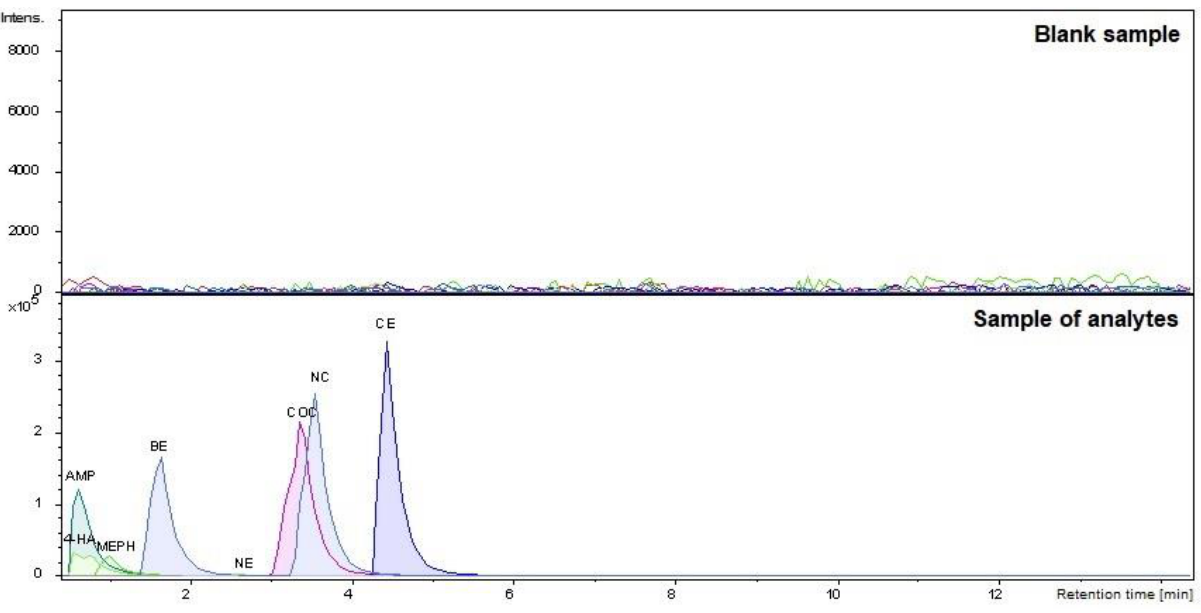
Figure 1. The chromatograms were obtained by applying the DI-SPME/LC-MS method for a blank blood sample and analyzed narcotic drugs at a concentration of 500 ng/mL. Peak assignment: 4- hydroxyamphetamine 4-HA (t R = 0.56 min); amphetamine — AMP (t R = 1.00 min); mephedrone — 4-hydroxyamphetamine 4-HA (t R = 0.56 min); amphetamine—AMP (t R = 1.00 min); mephedrone— MEPH (t R = 1.13 min); benzoylecgonine — BE (t R = 1.64 min); norephedrine — NE (t R = 2.59 min); co- MEPH (t R = 1.13 min); benzoylecgonine—BE (t R = 1.64 min); norephedrine—NE (t R = 2.59 min); caine — COC (t R = 3.36 min); norcocaine — NC (t R = 3.55 min); and cocaethylene — CE (t R = 4.44 min). cocaine—COC (t R = 3.36 min); norcocaine—NC (t R = 3.55 min); and cocaethylene—CE (t R = 4.44